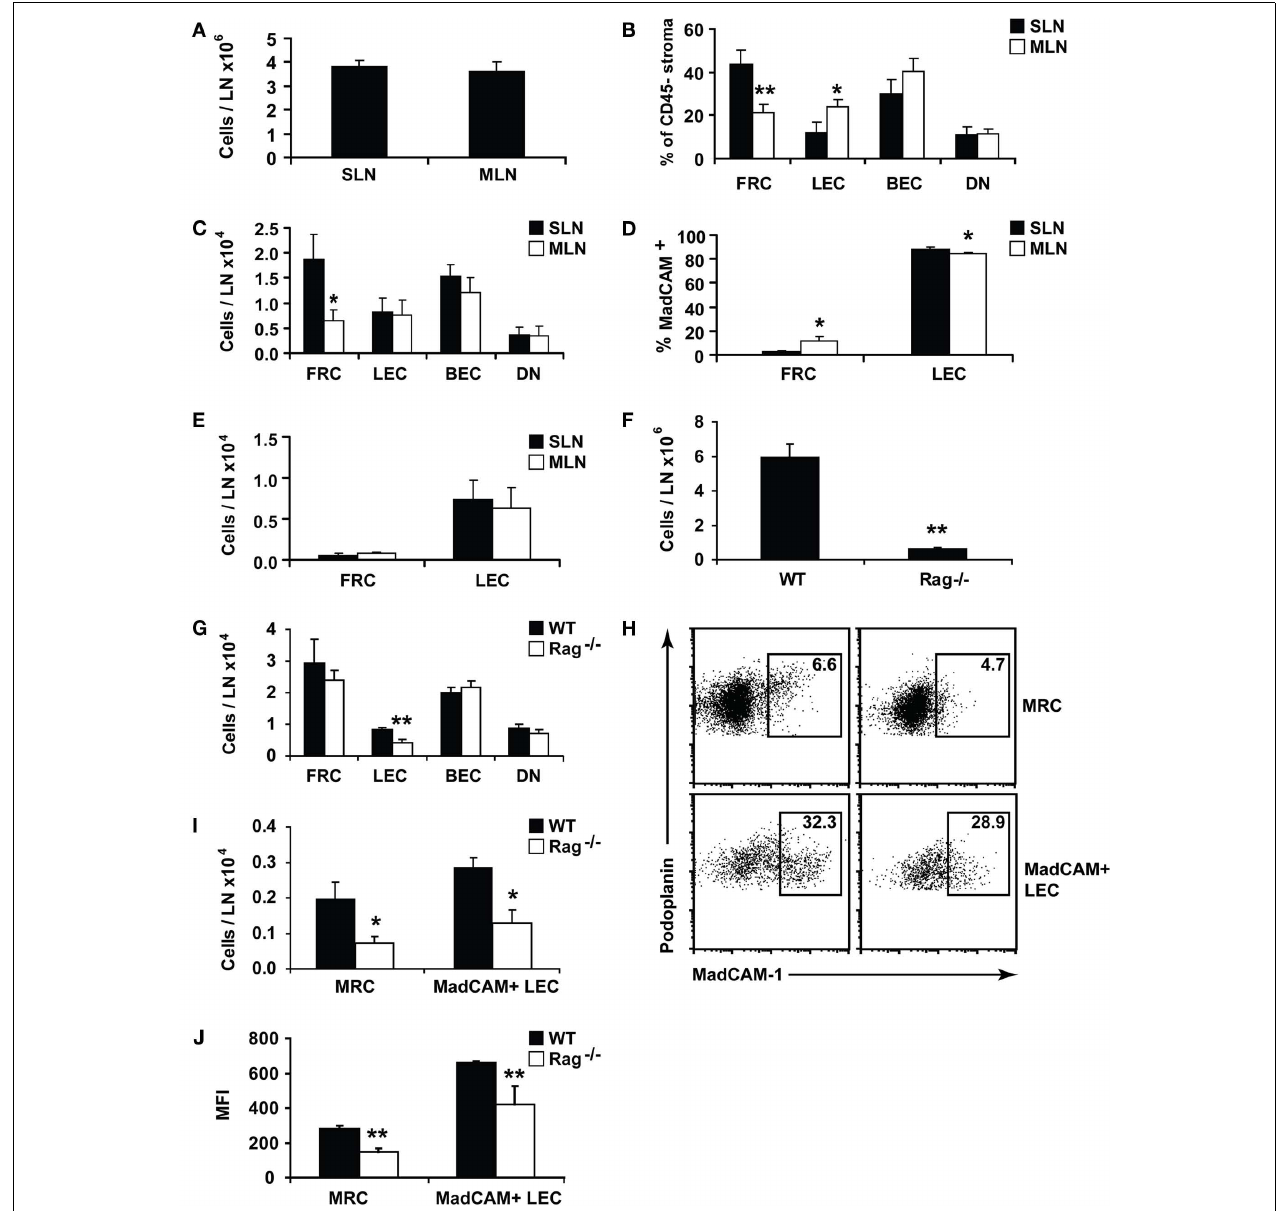
FIGURE 3 | Lymph nodes show site-specific alterations in stromal composition. Lymph nodes from individual C57Bl/6 mice were digested and stained for flow cytometry. (A) Lymph node cellularity. (B) Proportion of CD45 negative lymph node stromal subsets. (C) Number of lymph node stromal subsets. (D) MadCAM + cells shown as a proportion of total FRCs or LECs. (E) Total number of MadCAM + FRCs or LECs. (F) Cellularity of skin-draining lymph nodes isolated from age-matched Rag − / − orWT (B6)